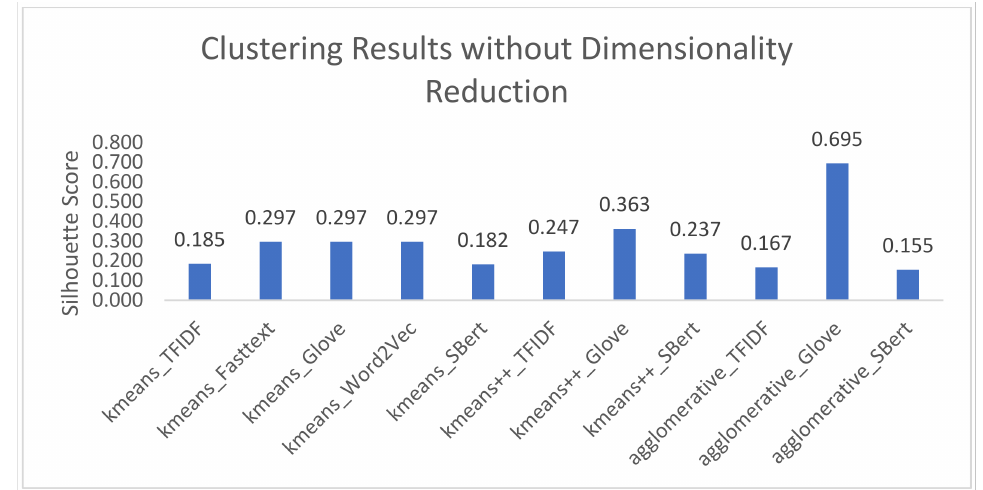
Figure 3. Clustering results in the new test settings on the baseball dataset.